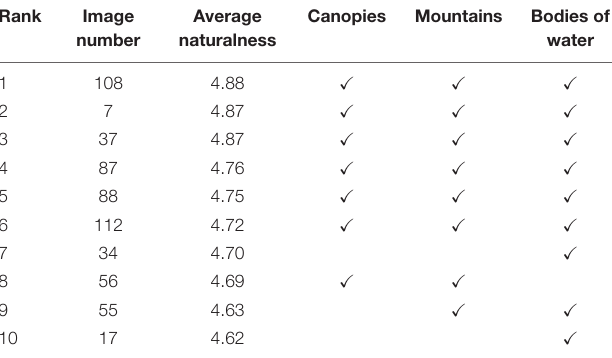
TABLE 5 | Top 10 highly representative nature images, average naturalness ratings, and semantic